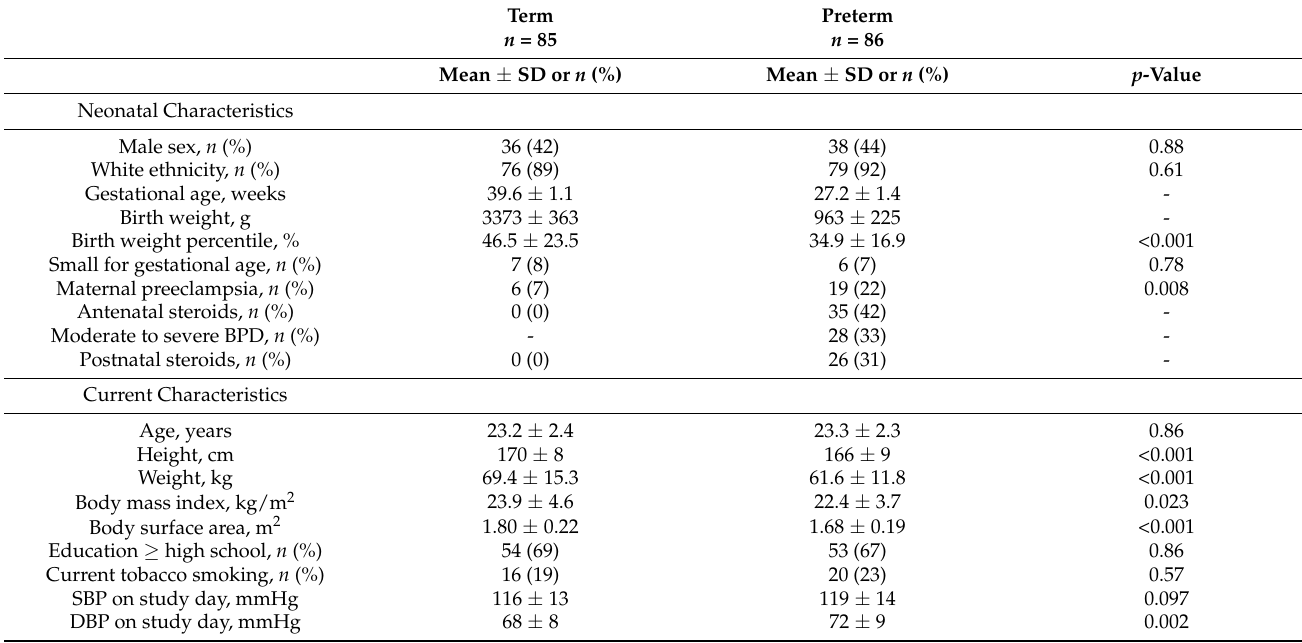
Table 1. Neonatal and Adult